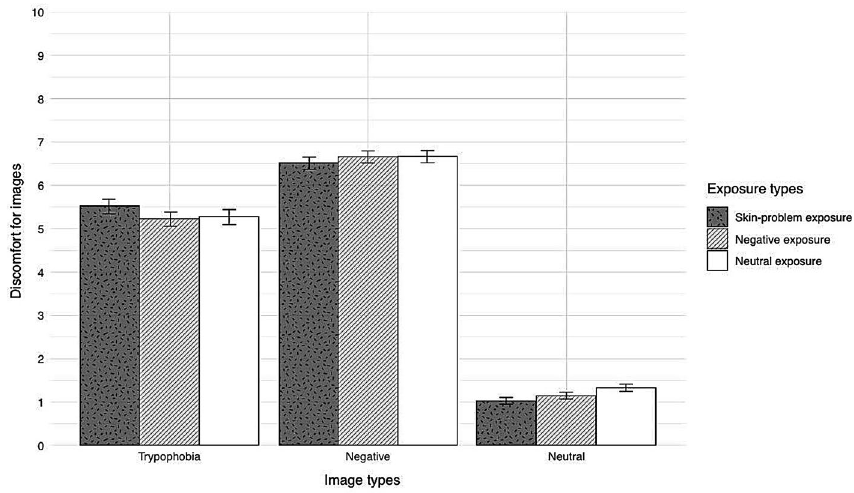
Figure 1. Mean discomfort of images per word type. Error bars indicate the standard error of the mean ( SEM ).